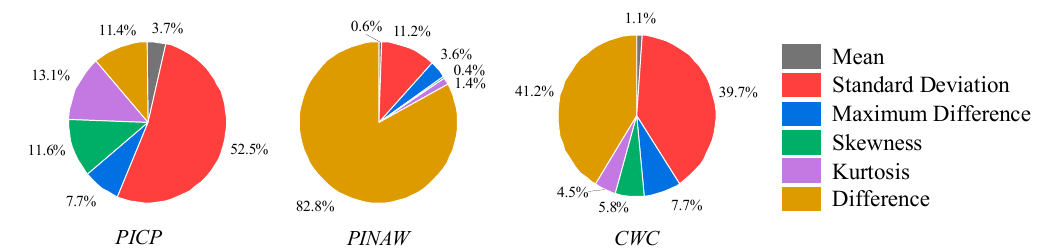
Figure 8. Regression coefficients.